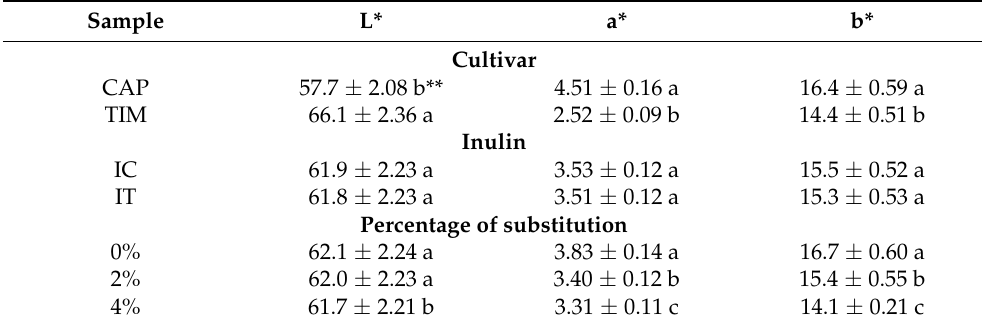
Table 2. Color indices of cooked spaghetti (mean ± SD, n = 3) as affected by cultivar, inulin-type, and percentage of substitution.